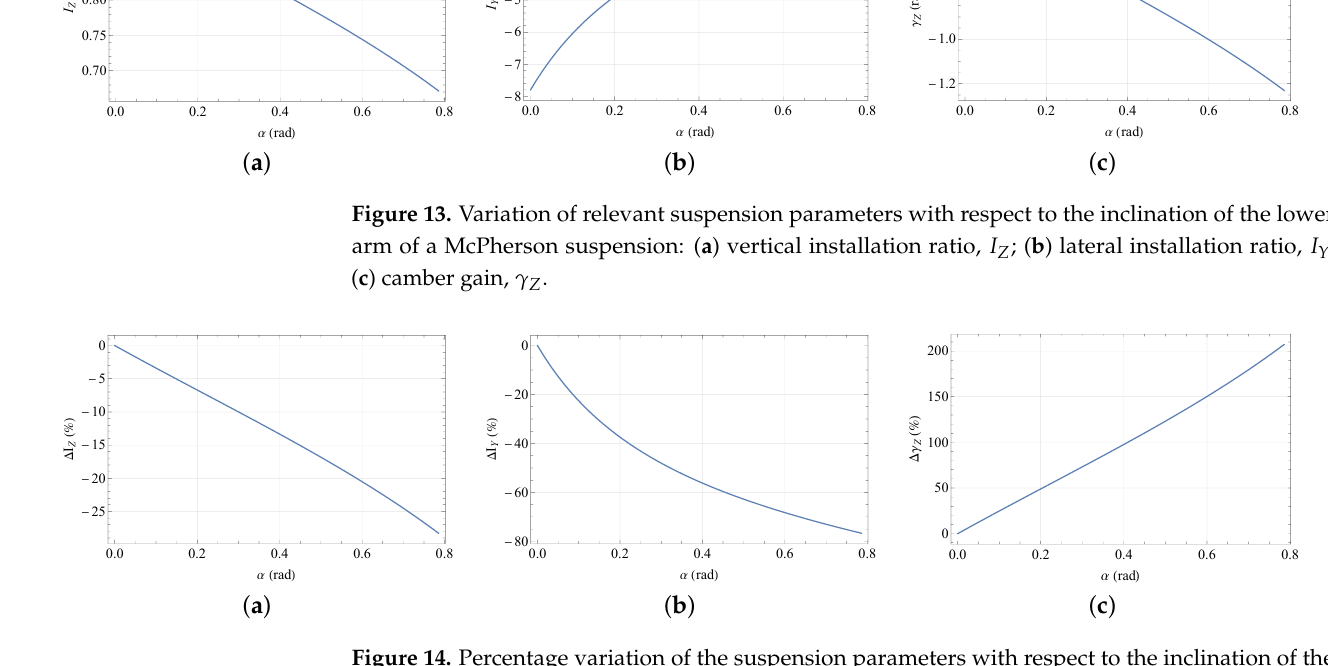
Figure 14. Percentage variation of the suspension parameters with respect to the inclination of the lower arm of a McPherson suspension: ( a ) vertical installation ratio, I Z ; ( b ) lateral installation ratio, I Y ; ( c ) camber gain, γ Z